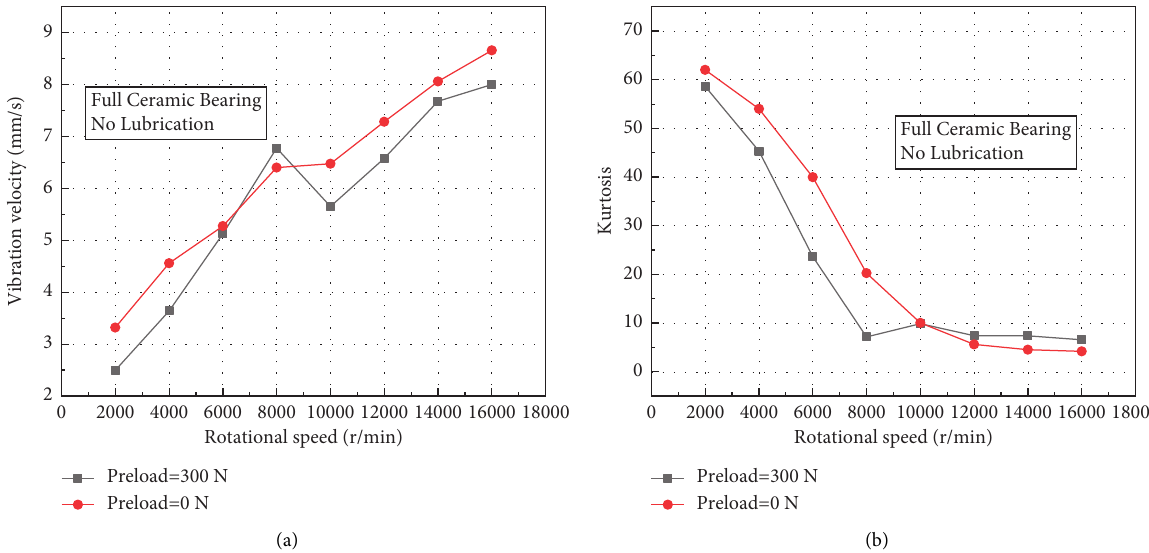
Figure 7: Variation of vibration velocity and kurtosis for Si (b)